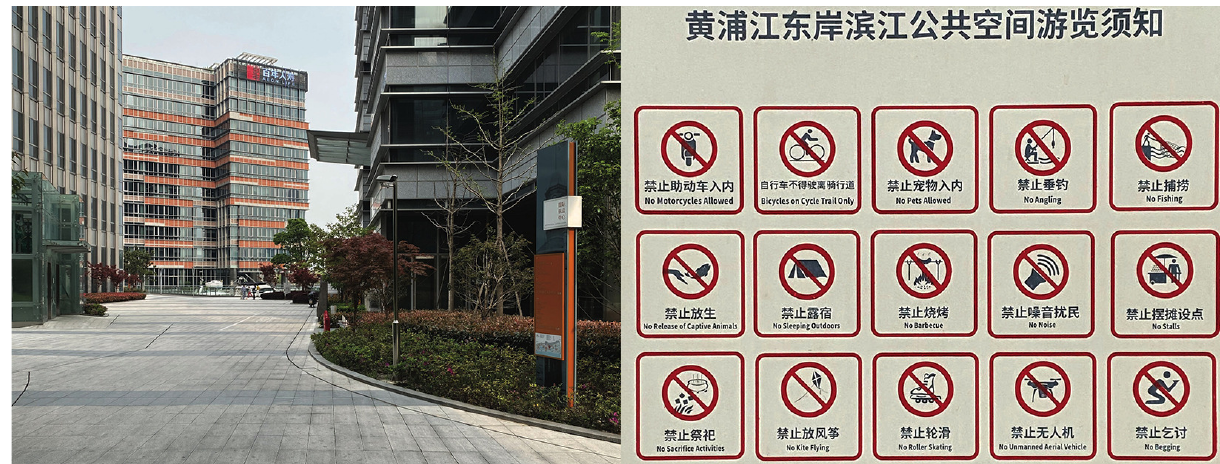
Figure 6. Multiple vacant offices, here at North Bund, and limitations in the use of public space, here on former Expo 2010 site. Source: Author (Autumn